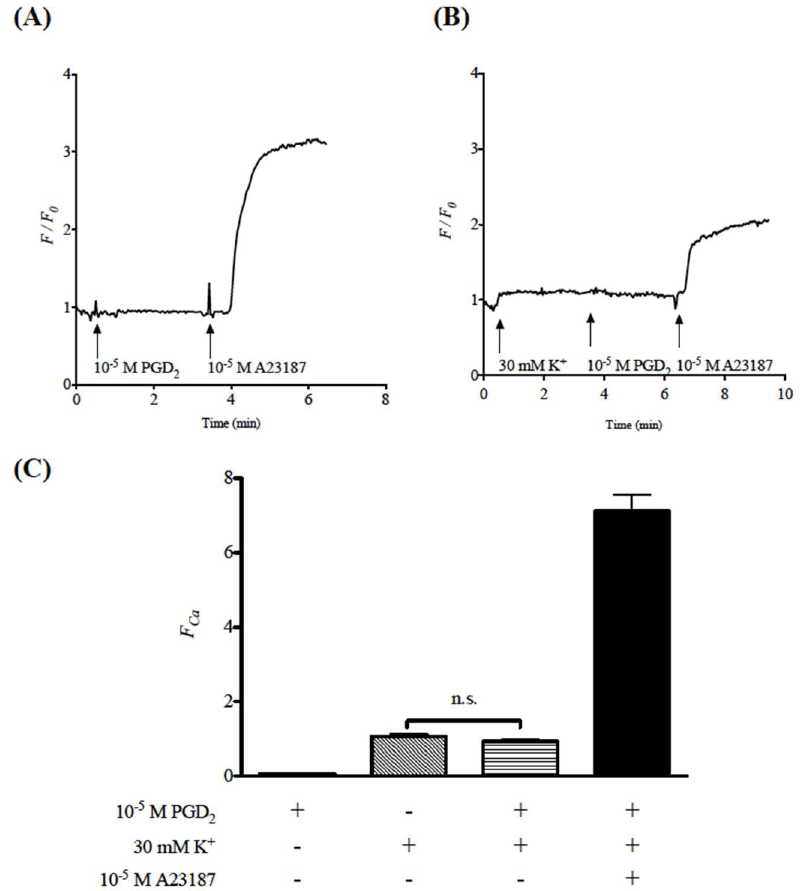
Figure 4. Effects of prostaglandin D 2 (PGD 2 ) on the cytosolic Ca 2+ level in cultured human bronchial smooth muscle cells (hBSMCs) determined by a fluorescent Ca 2+ indicator Fluo-8. ( A , B ) Representative trace of change in cytosolic Ca 2+ ( F / F 0 , ratio of the Ca 2+ fluorescence intensity to that at time 0 (baseline)). The Fluo-8-loaded hBSMCs were stimulated with 30 mM K + and, when its stable response was observed, 10 − 5 M PGD 2 was applied. To confirm the maximal response, a Ca 2+ ionophore A23187 (10 − 5 M) was applied at the end of experiments. ( C ) Summary of normalized ratios of the Ca 2+ fluorescence intensities ( F Ca ) data. Results are presented as mean ± SEM from 8 independent experiments. Note that neither the baseline Ca 2+ level nor the stable increase in Ca 2+ induced by K + depolarization was affected by PGD 2 .